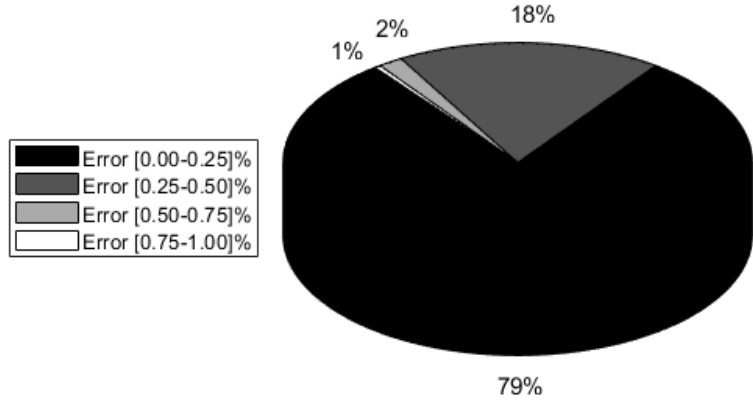
Figure 9. Error distribution in % of forecaster 3 (period January–August 2018).